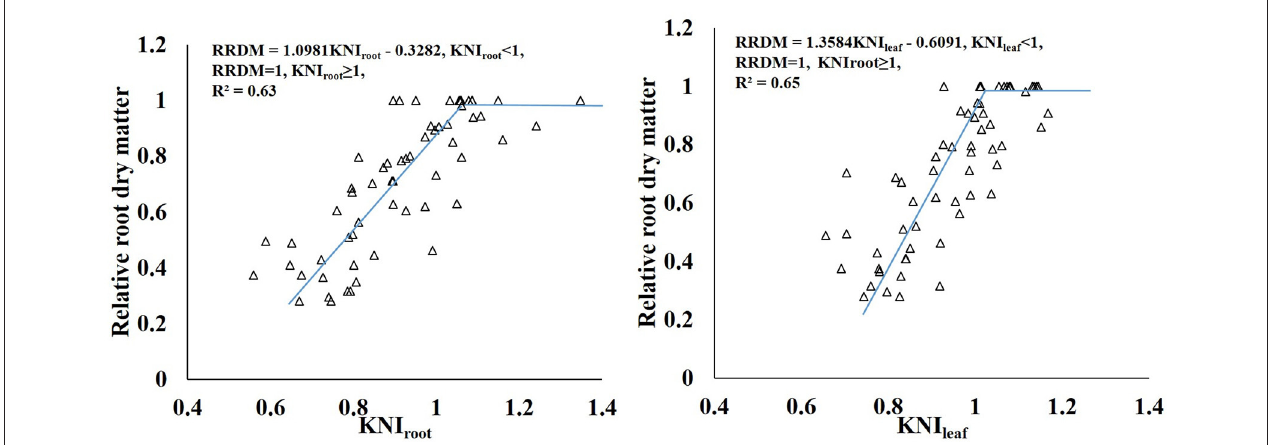
FIGURE 11 | Relationship between relative RDM and the KNI of sweet potato grown under different K